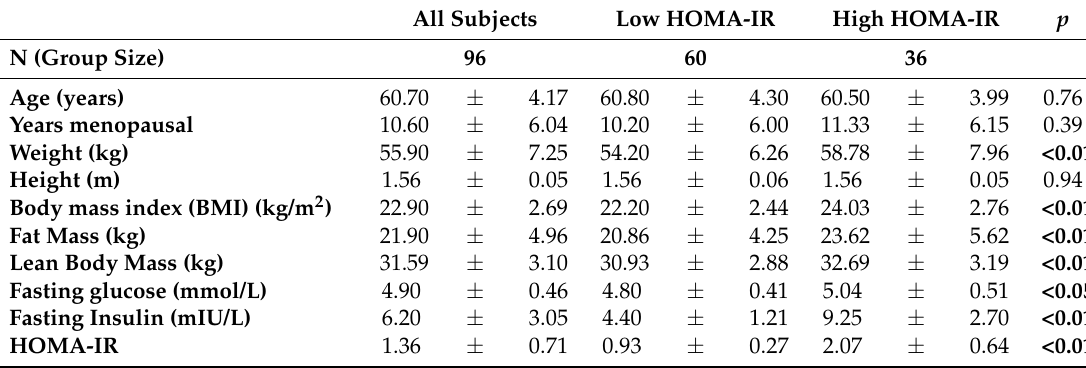
Table 1. General characteristics of the total study population, “Low HOMA-IR” and “High HOMA-IR” groups and p values calculated by means of two-tailed t-tests between the two HOMA-IR groups. All Subjects Low HOMA-IR High HOMA-IR p N (Group Size) 96